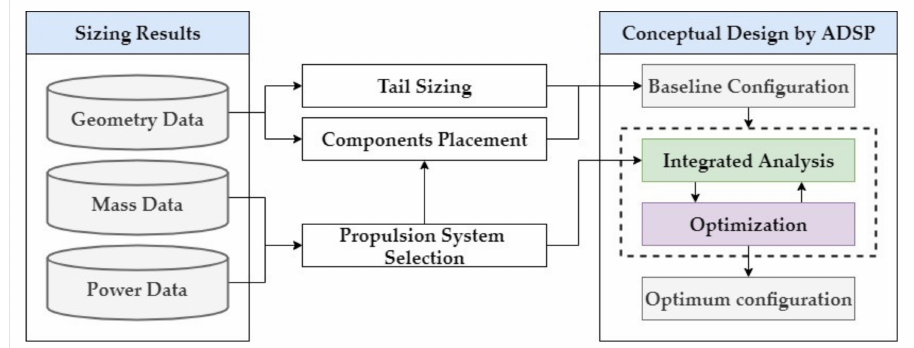
Figure 15. Conceptual design process through ADSP.